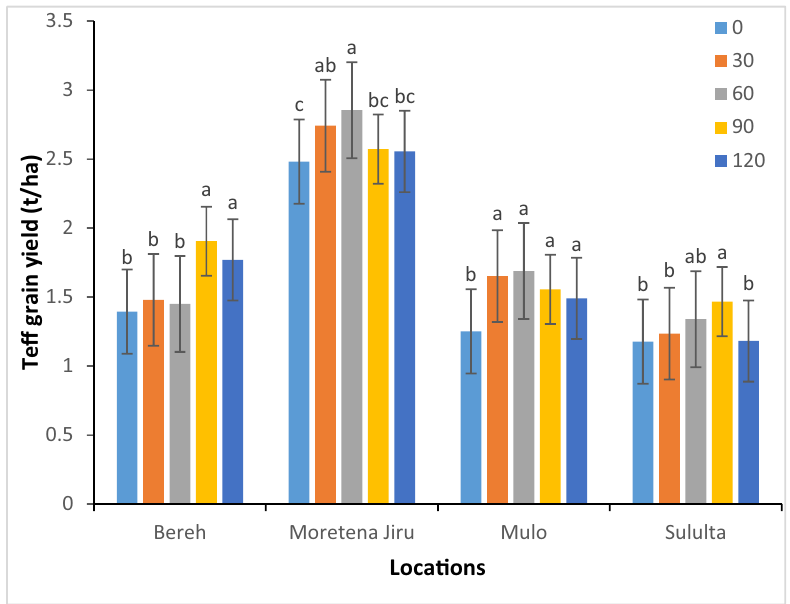
Figure 4: Location by treatment interaction e ff ect on te ff grain yield. The bars indicate standard errors of means and there is no signi fi cant di ff erence between means with similar